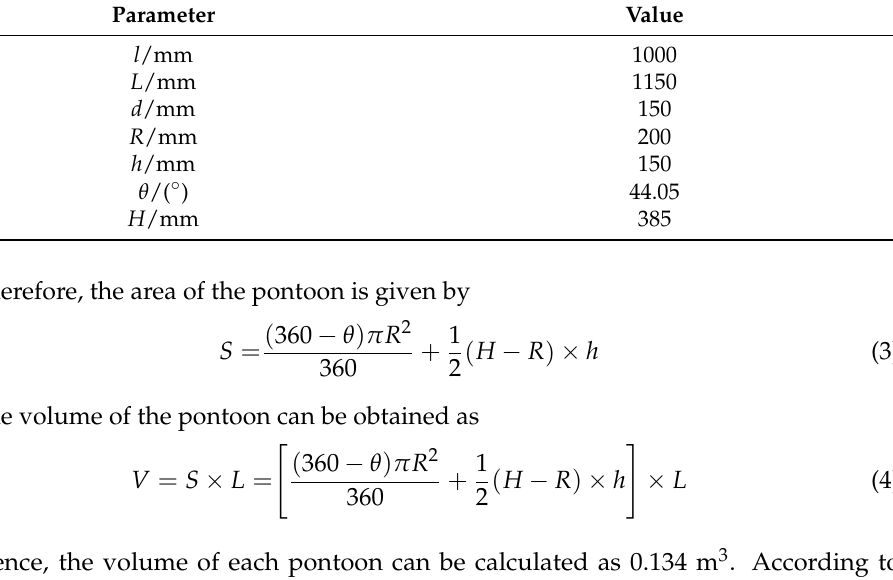
Table 4. Structural parameters of the pontoon.